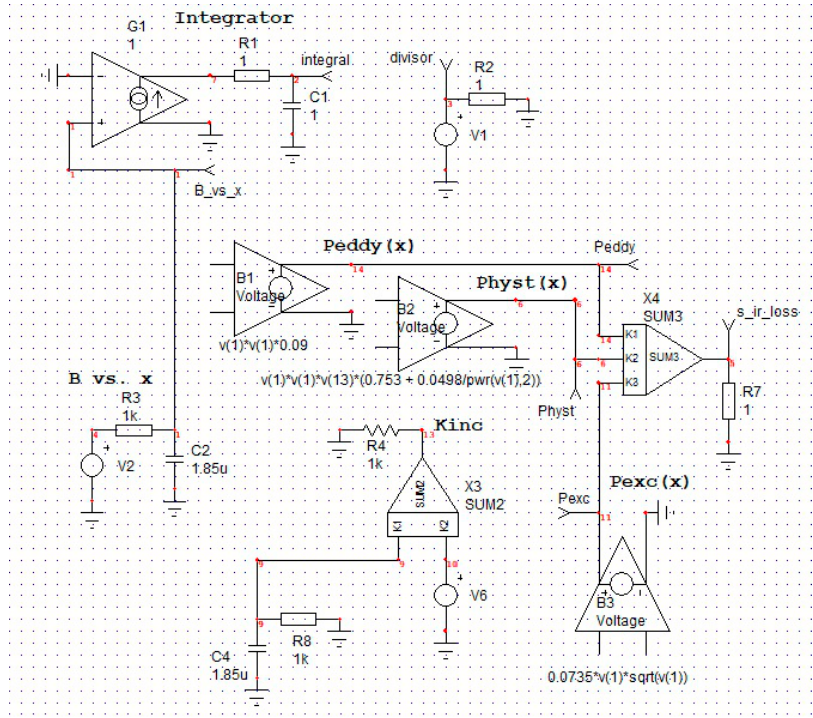
Figure 3. Electrical diagram of the circuit representing changes in the material properties of punched laminations.